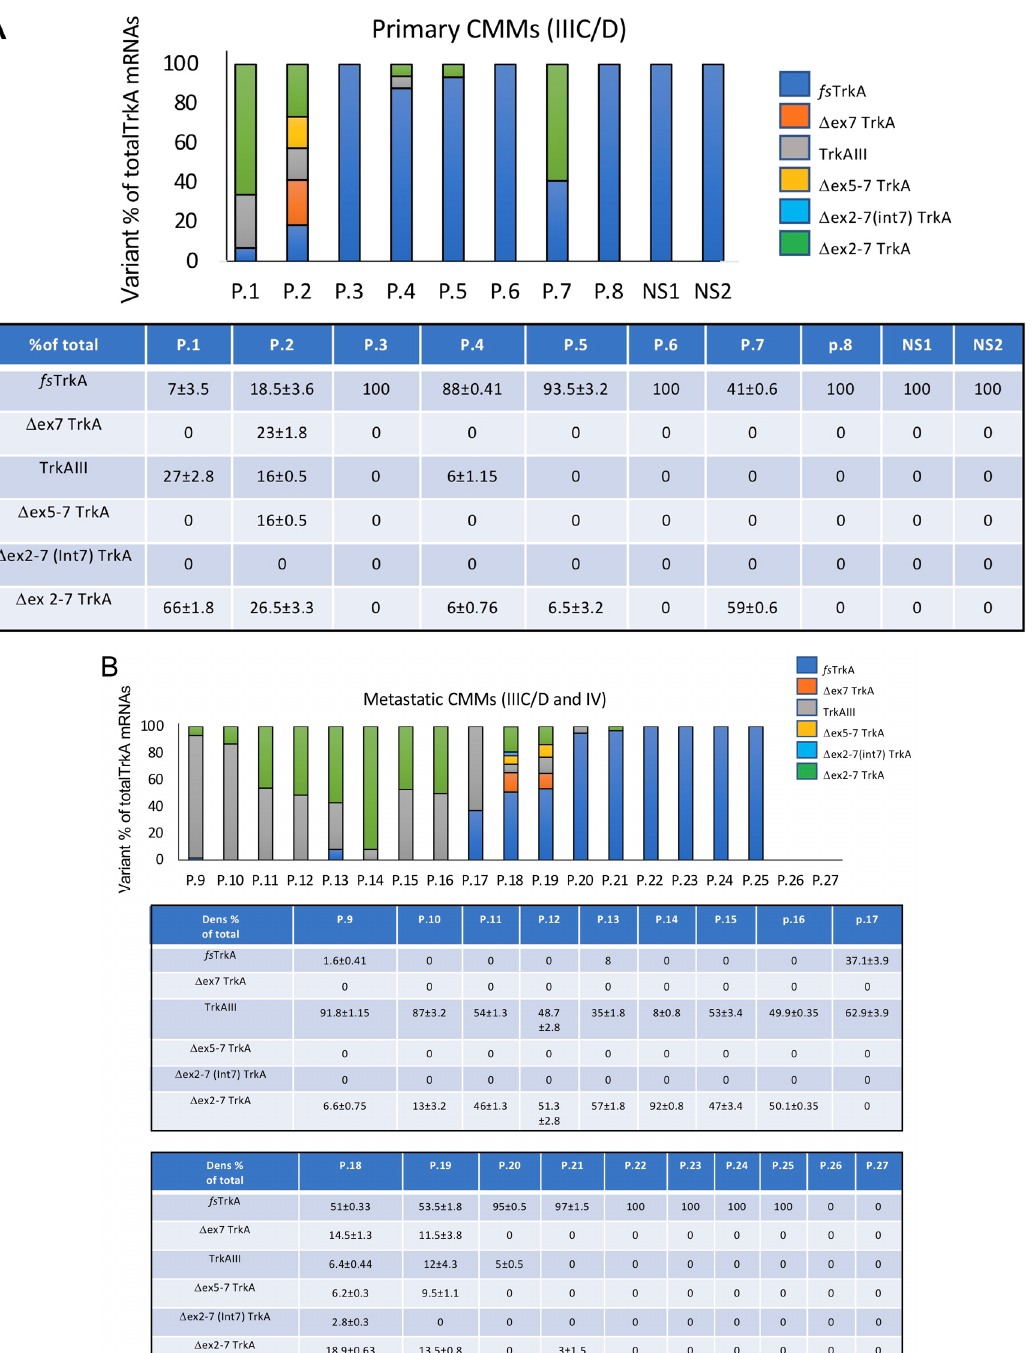
Figure 2. Alternative TrkA mRNA splicing ranges from exclusive fully spliced TrkA to almost exclusive TrkAIII expression in CMMs. Histograms and accompanying tables demonstrating differences in fully spliced ( fs ) TrkA, Δexon7 TrkA, TrkAIII, Δexon 5–7TrkA, Δexon 2–7(Int 7)TrkA and Δexon 2–7TrkA RT-PCR products, as densitometric mean ± s.e. percentages of all variants in: ( A ) 8 snap-frozen primary CMMs (upper histogram and table) and ( B ) 19 snap-frozen metastatic CMMs (lower histogram and table). The distribution of TrkA splice variants in histograms is enumerated in the accompanying tables, as the mean ± s.e. of each individual variant as a percentage (%) of all variants in each individual patient, in duplicate RT-PCRs repeated twice (see Supplementary Figures S1, S2 and S4, for all RT-PCRs).